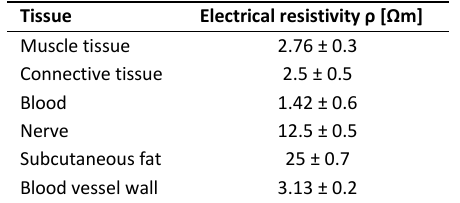
Table 1: The electrical resistivity of forearm biological tissues.